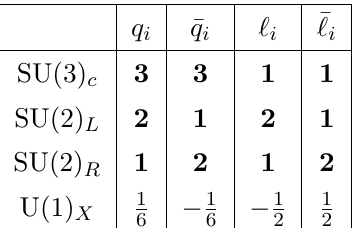
Table 1 . The minimal fermion content of a theory with SU(3) c × SU(2) L × SU(2) R × U(1) X gauge